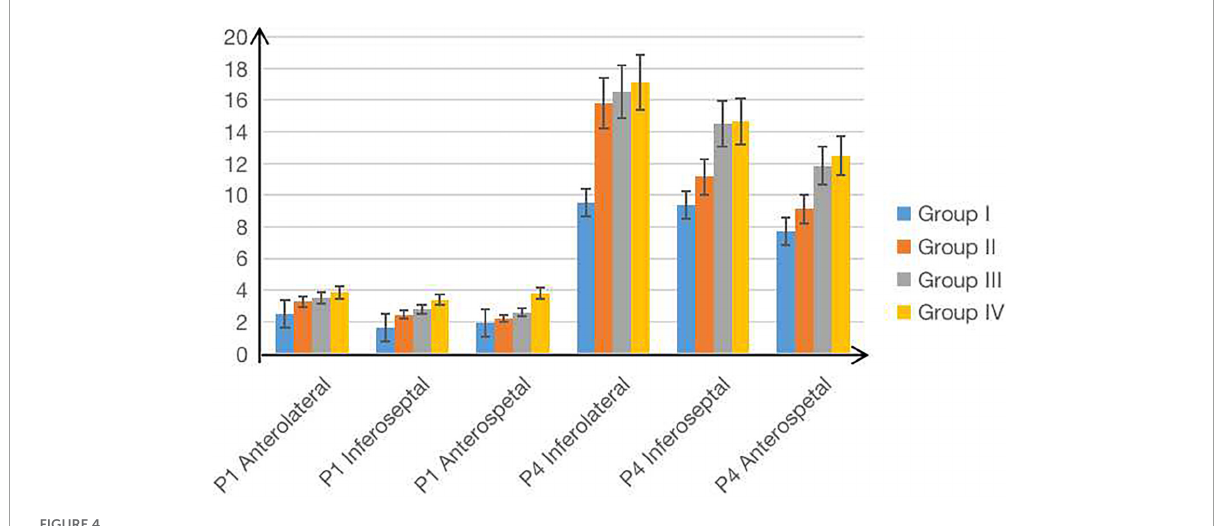
for future research on patients with certain diseases. In general, diastolic dysfunction often occurs prior to systolic dysfunction. Therefore, early detection of diastolic LV WSS is very important.